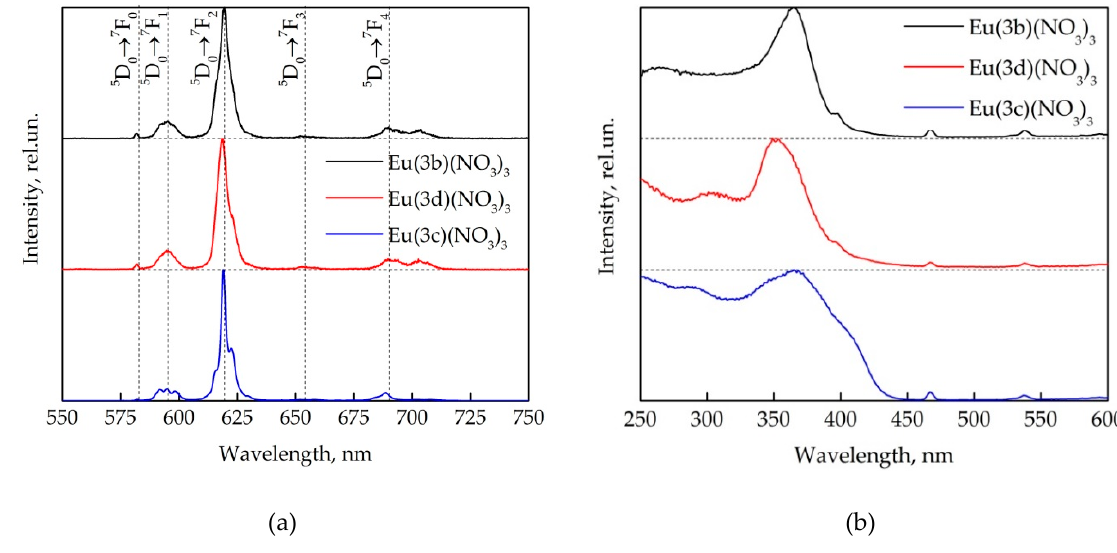
Figure 6. ( a ) Luminescence emission spectra of europium complexes in solid state, excitation wavelength λ ex = 320 nm and ( b ) luminescence excitation spectra of europium complexes in solid state, emission wavelength λ em = 618 nm.